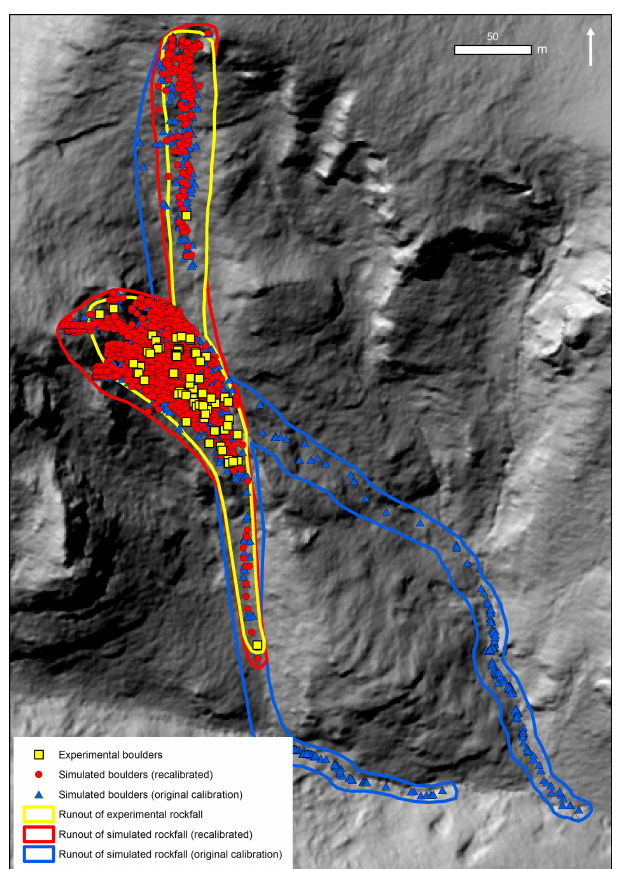
Figure 8. Comparison of Mt Vernon experimental rockfall ( n = 70) runout envelope (yellow line) with simulated rockfall using the ini- tial calibration parameters (blue line = dry) and modified parame- ters (red line = wet) (boulder n =